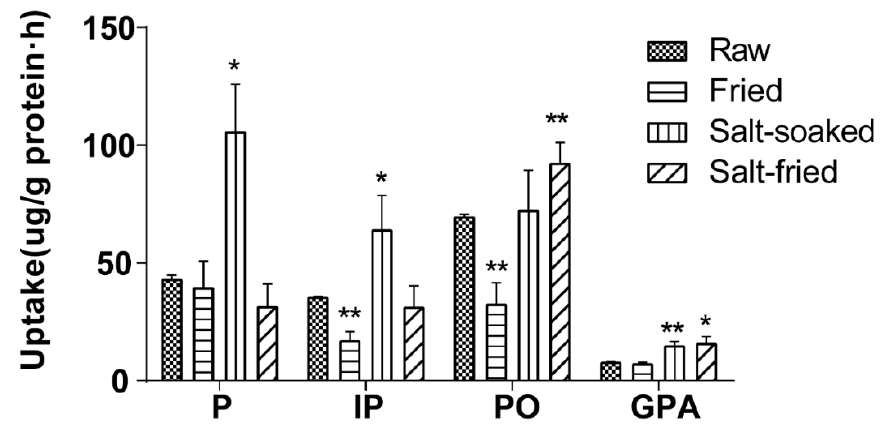
Figure 8. The cellular uptake of the 4 component compounds in drug-contained medium of various extracts of Qing’e Pills. Significance: vs. raw group (blank group): * p < 0.05, ** p < 0.01.